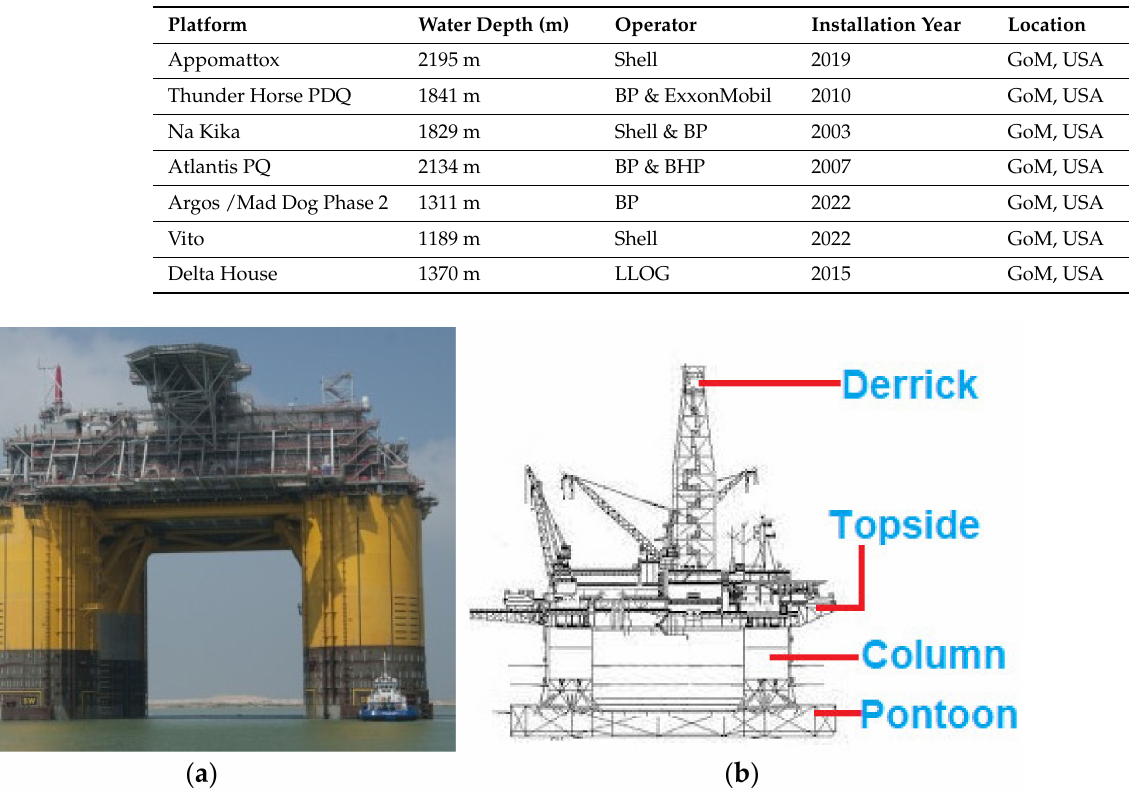
Figure 10. Semisubmersibles showing ( a ) Appomattox Semi-Submersible oil platform in GoM installed in 2019 (Courtesy: Shell), and ( b ) an illustration of part of a